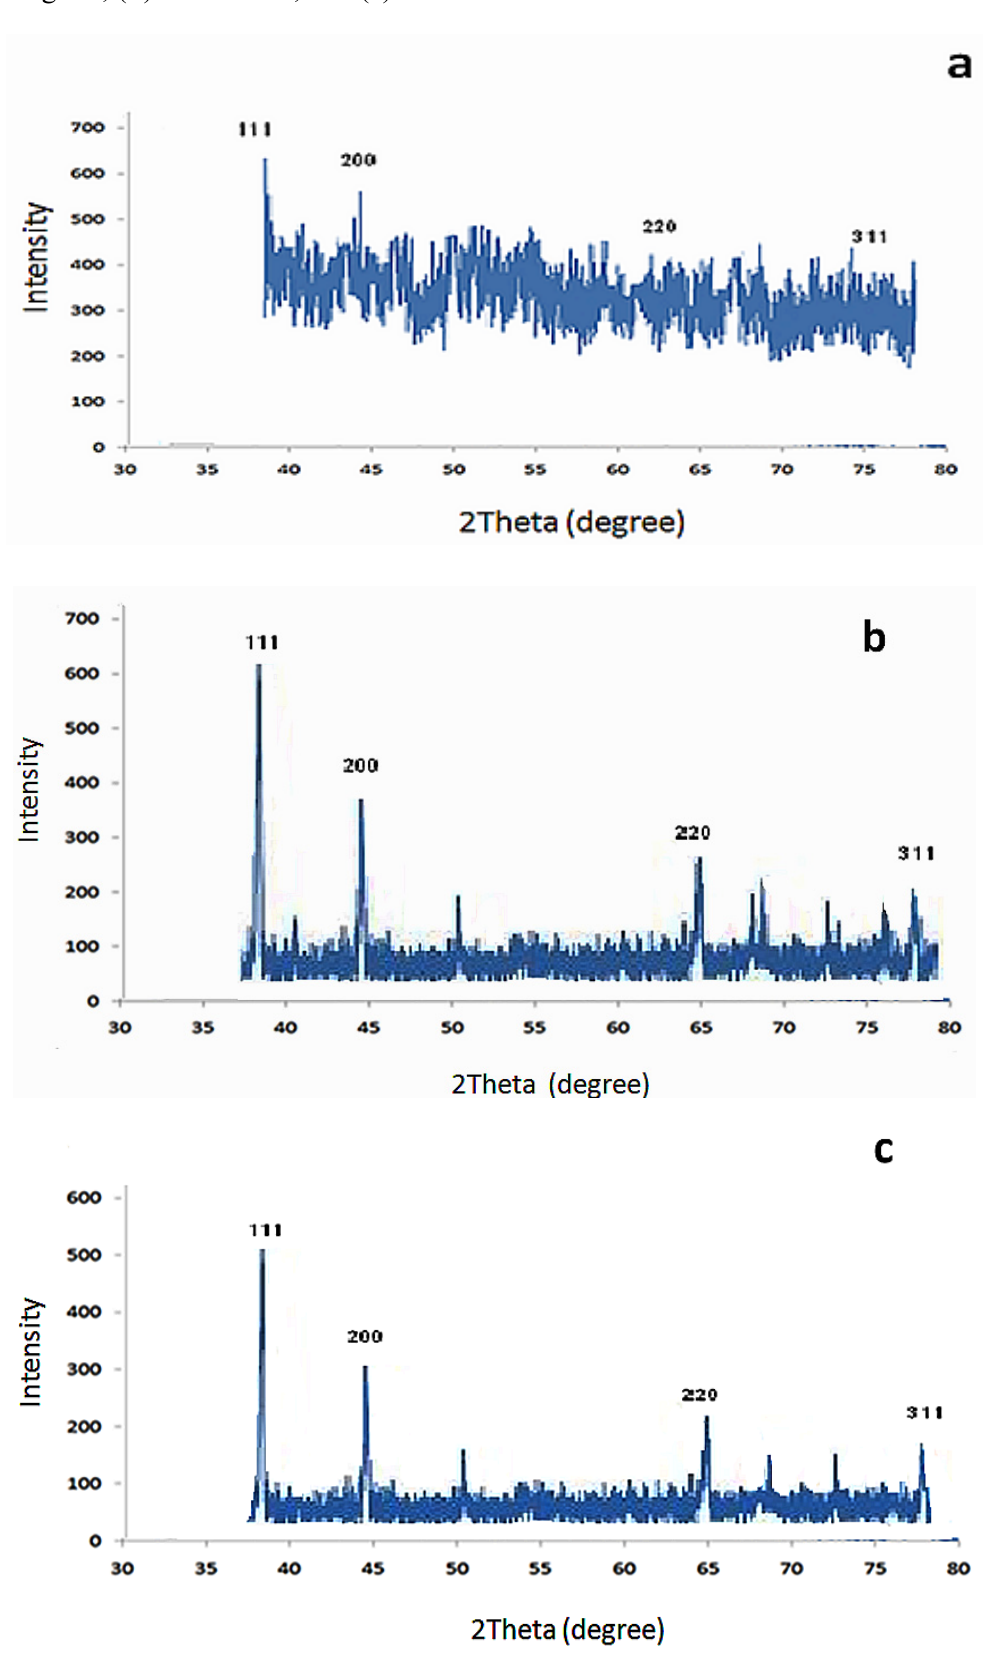
Figure 4. XRD patterns of the silver nanoparticles coated on ( a ) zeolite, ( b ) sand, ( c ) fiberglass, ( d ) anion resin, and ( e ) cation